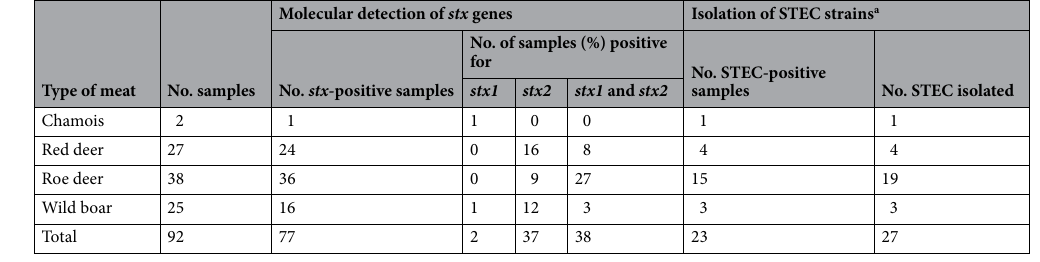
Table 1. Detection of stx genes by PCR and isolation of Shiga toxin-producing Escherichia coli (STEC) strains from 92 samples of game meat. a PCR positive samples were further cultured and at least one STEC was isolated by growth on Brolacin agar or CHROMagar™. For details see